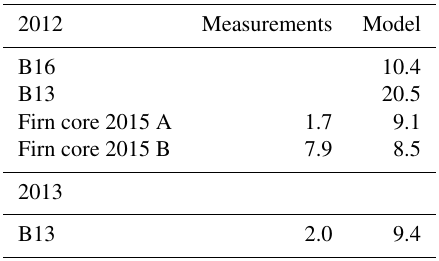
Table 1. Total dust deposition [gm − 2 ] at stations on Brúarjökull in 2012 and 2013. Drill site A (Fig. 1) is situated at station B15, drill site B at 600m below B15 at 1400m